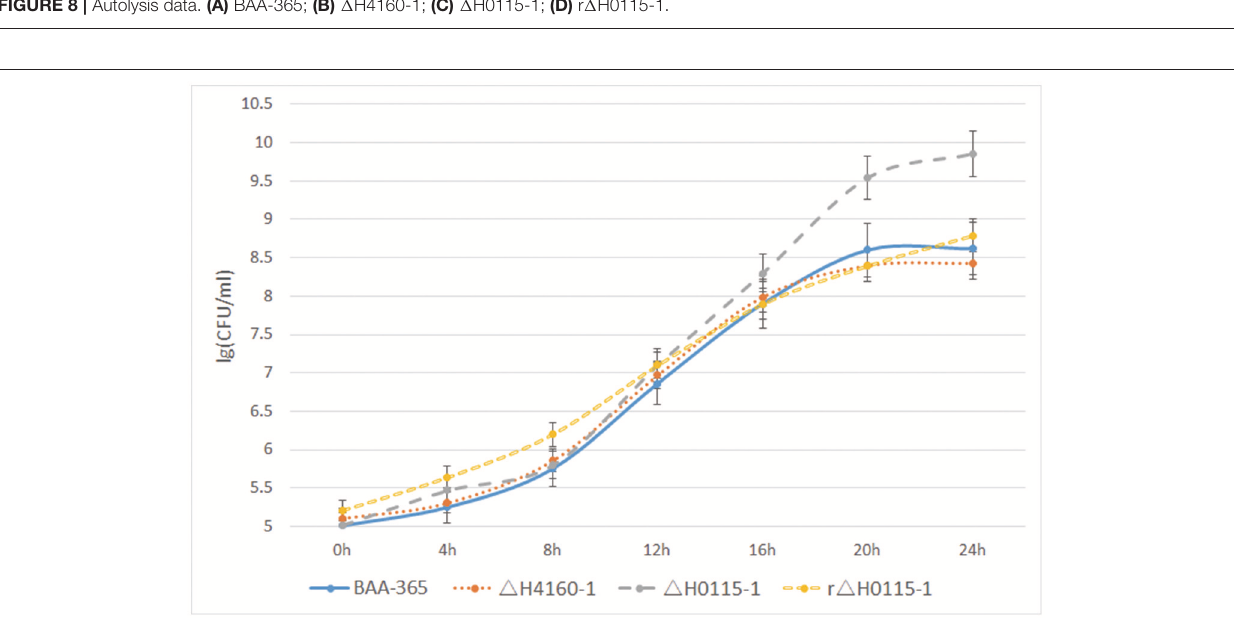
FIGURE 9 | Results of colony counts (lg CFU/ml). The number of viable bacteria per milliliter of bacteria was measured by colony counts at different time points (0, 4, 8, 12, 16, 20, 24 h).